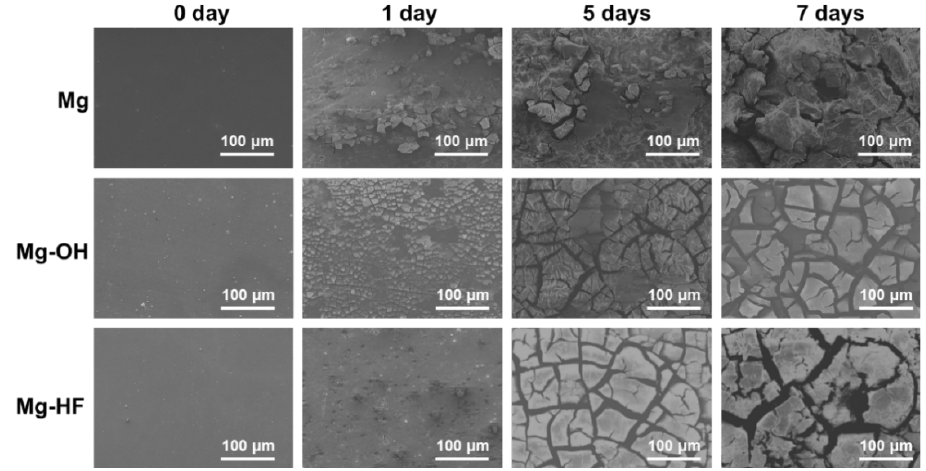
Figure 5. The typical scanning electron microscope (SEM) images of the different samples immersed